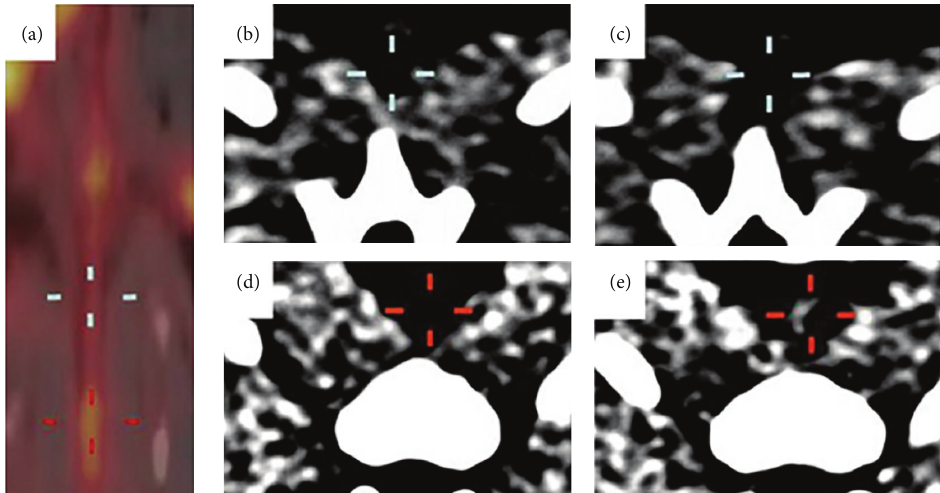
Figure 1: N1177-enhanced CT and corresponding FDG PET from atherosclerotic rabbit. Fused PET/CT coronal view of aorta obtained 3 hours after injection of 18F-labeled fluorodeoxyglucose (FDG) and corresponding axial aortic sections acquired before (b and d) and at 2 hours after injection of N1177, an iodine-based contrast agent that accumulates in macrophages (c and e). Aortic regions with high ((a), red cross) and low ((a), white cross) activities identified with PET at 3 hours after injection of FDG were associated with strong ((e), red cross) and weak ((c),white cross) intensities of enhancement detected in CTat 2 hoursafter injection of N1177 on corresponding axial views, respectively. Reprinted with permission from Hyafil et al.